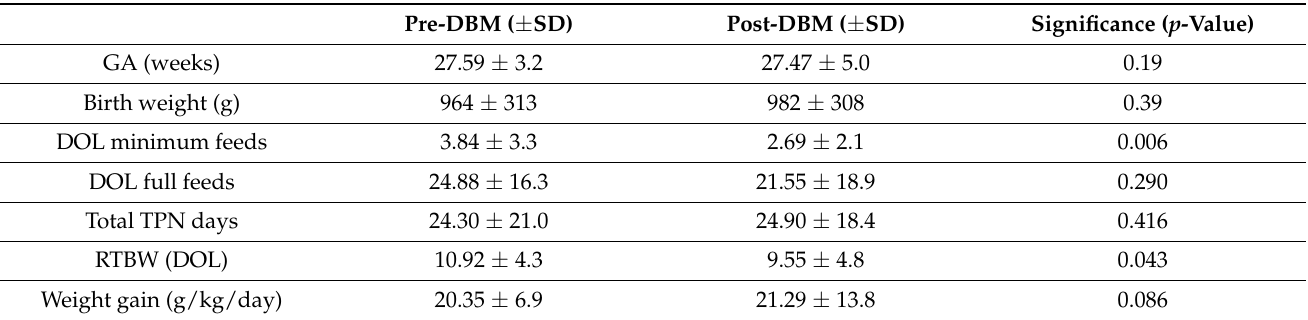
Table 1. Comparison of mean nutritional and growth outcomes before and after the introduction of donor breast milk. Pre-DBM ( ±